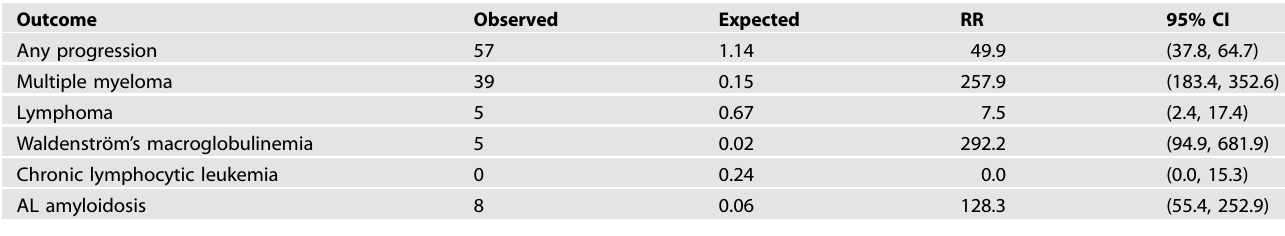
Table 2. Risk and type of progression in the overall MGUS cohort.